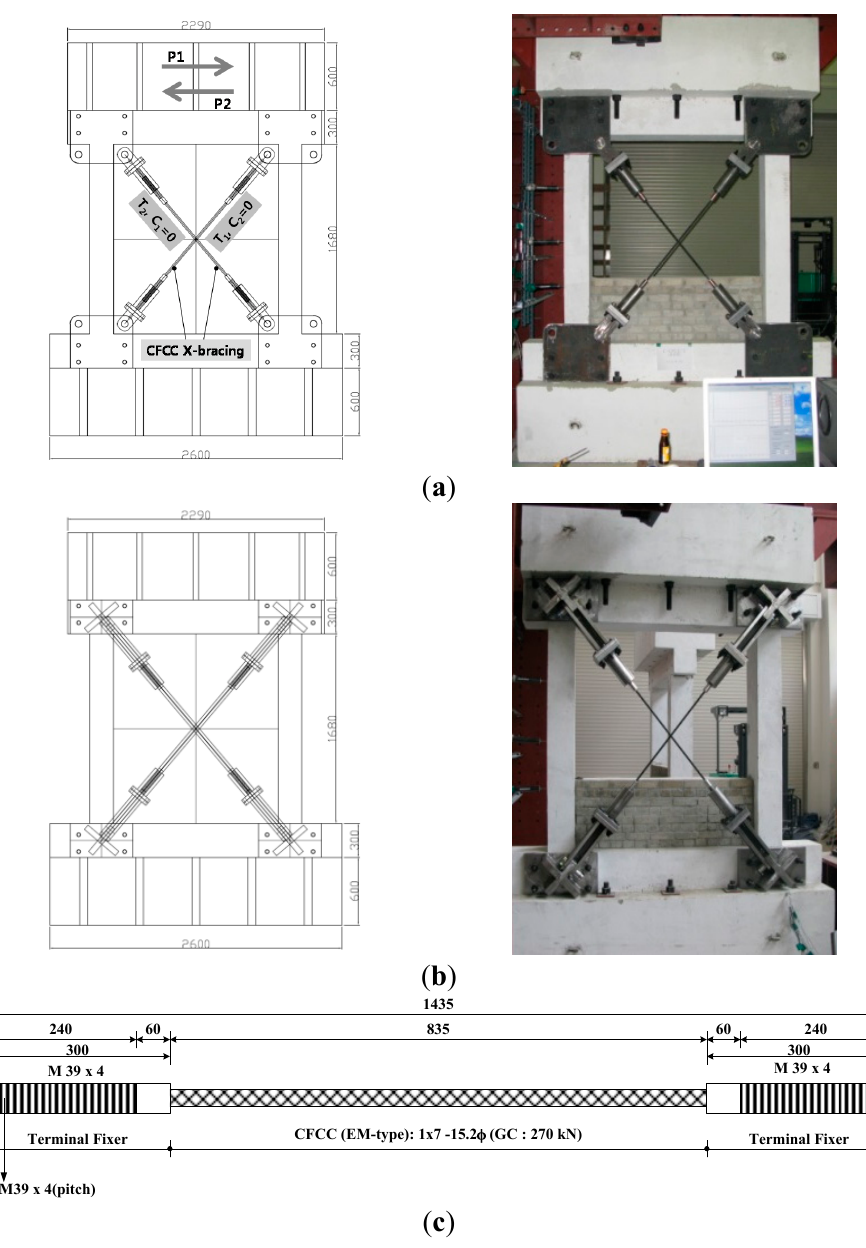
Figure 3. Seismic reinforcement methods using CFCC X-Bracing: ( a ) Flat-plate and ( b ) protrusion configurations. ( c ) Details of an individual CFCC reinforcement.